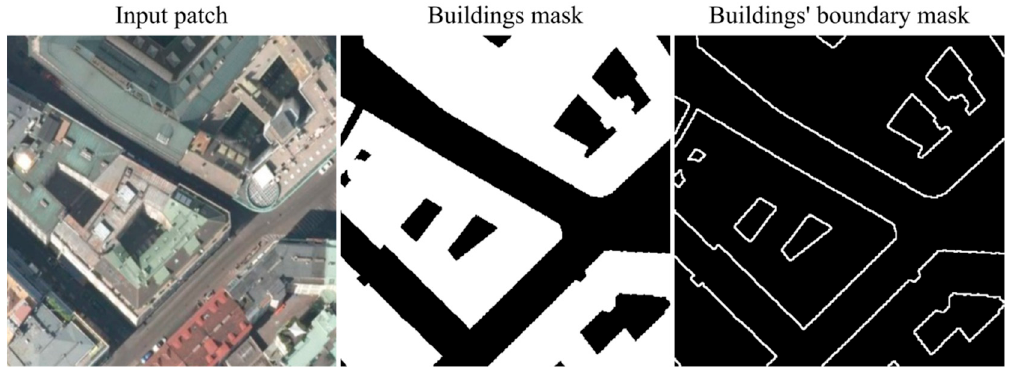
Figure 8. An illustration of the derived buildings’ boundary mask channel that is used during the training of the segmentation model.